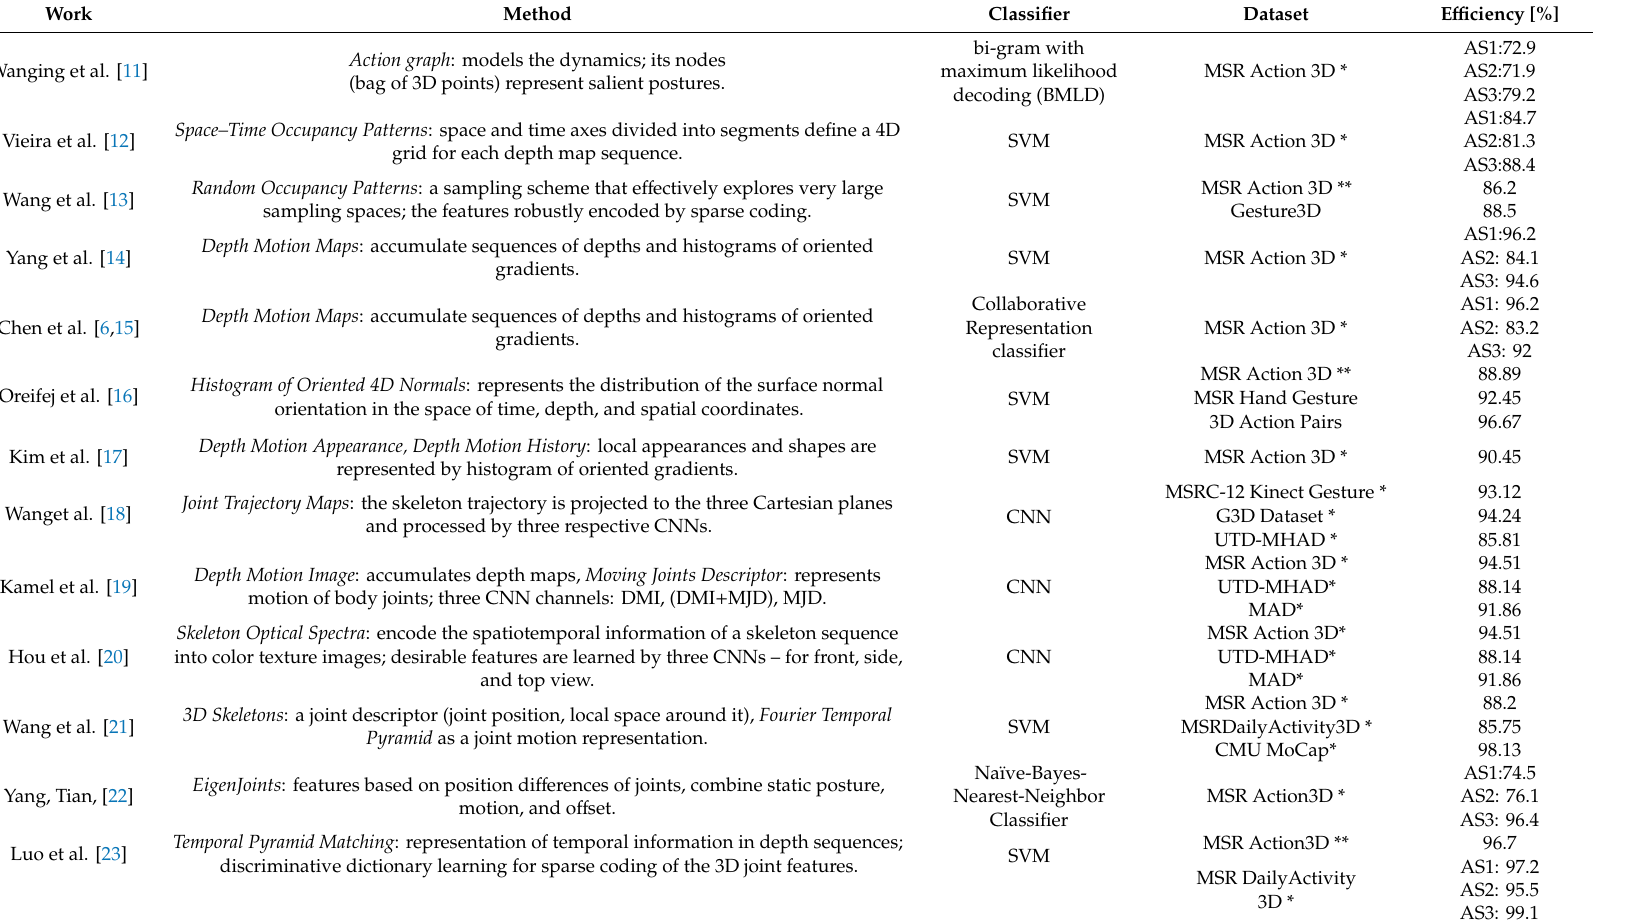
Table 1. Representative works using depth data for activity